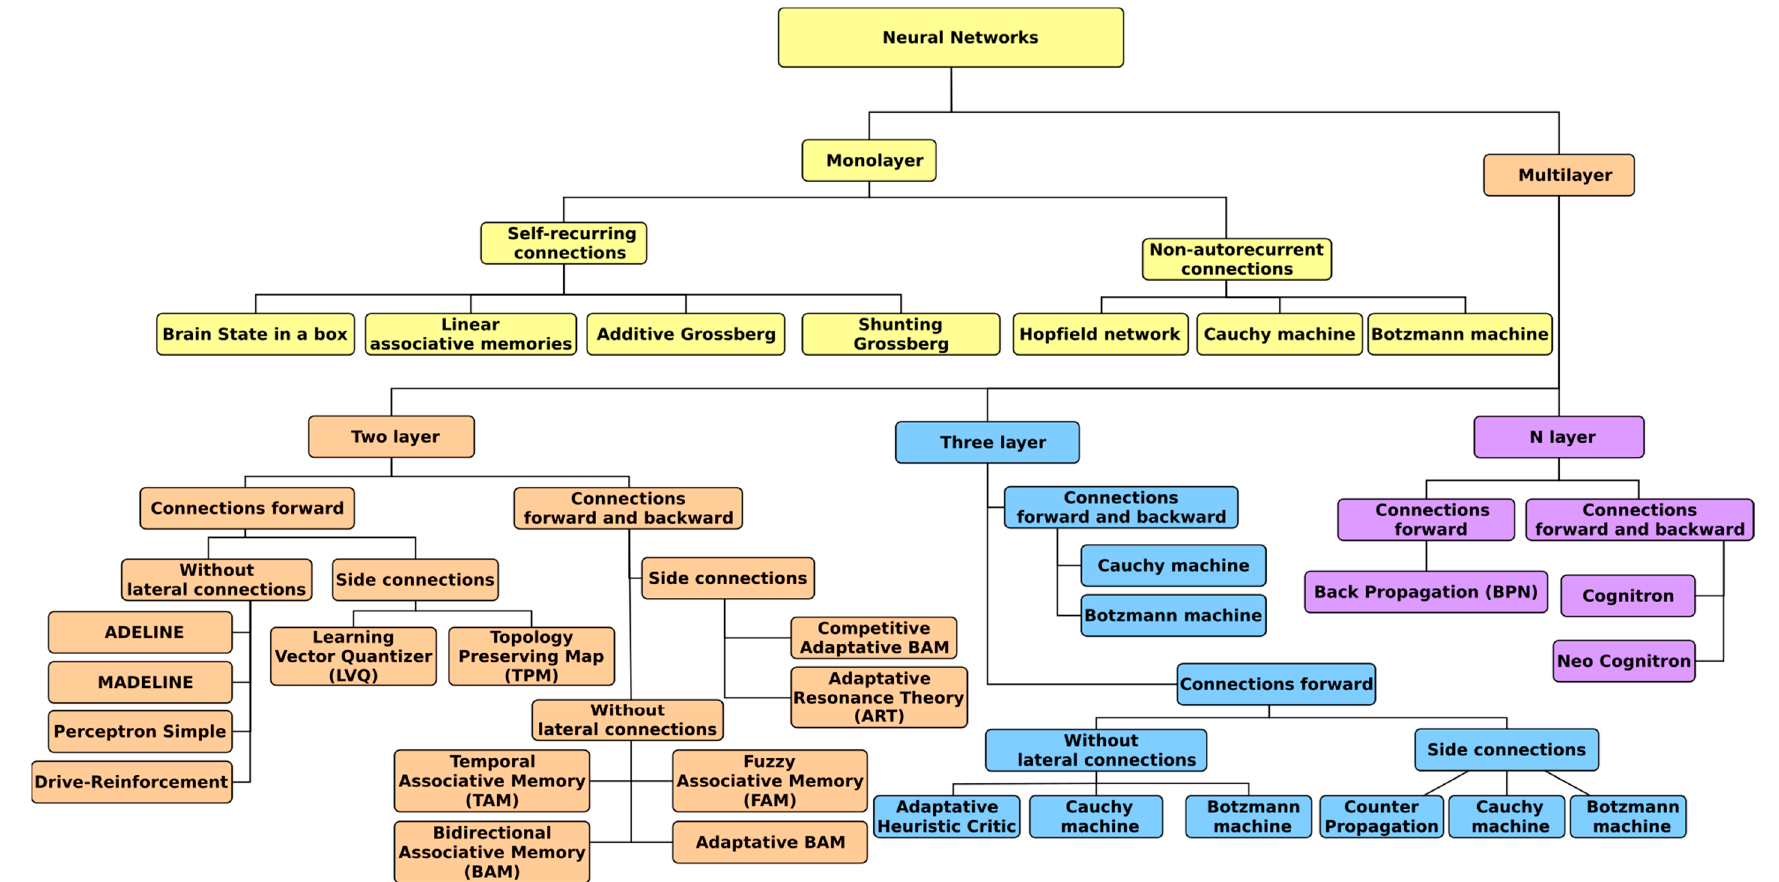
Figure 14. Classification of Artificial Neural Network (ANN), models. Modified from [185].